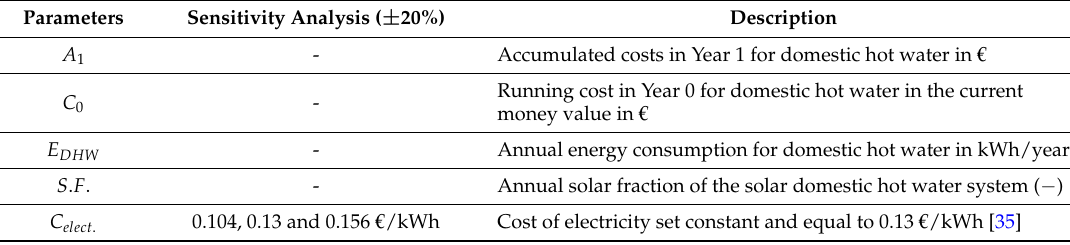
Table 3. Description of the input parameters used in the life cycle